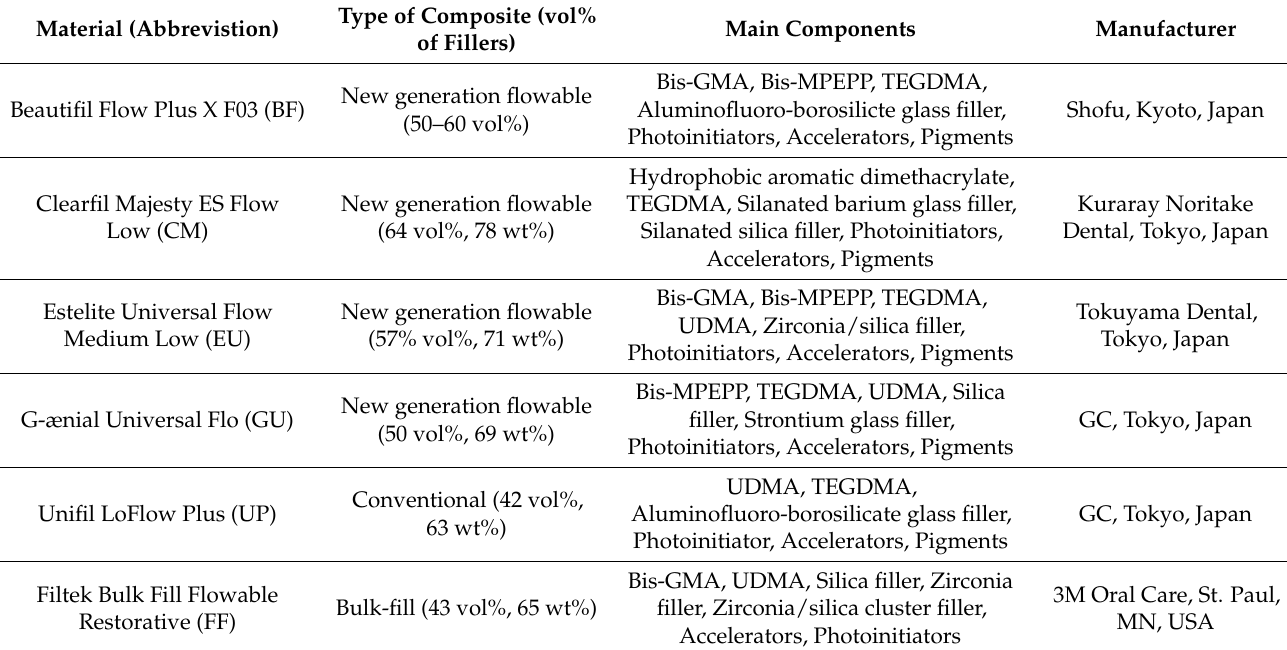
Table 1. Flowable composites used in this study.